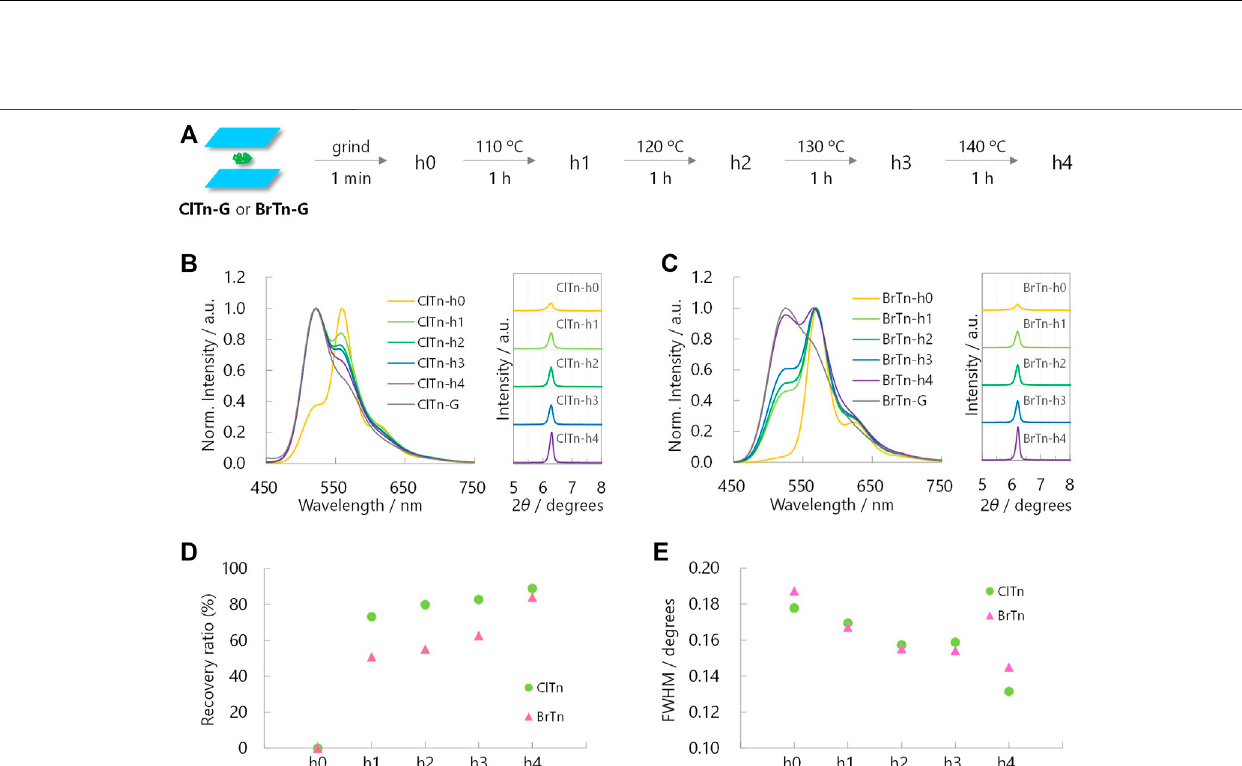
FIGURE 7 | Normalized PL spectra of (A) ClTn-G and (B) BrTn-G upon mechanical stimulation ( λ ex (cid:2) 320 nm). Angles in the legends are the rotating angles as depicted in the bottom right. (C) Sensitivity of RTP color to mechanical stimulation. See Experimental Section for de fi nition of the color change ratio.